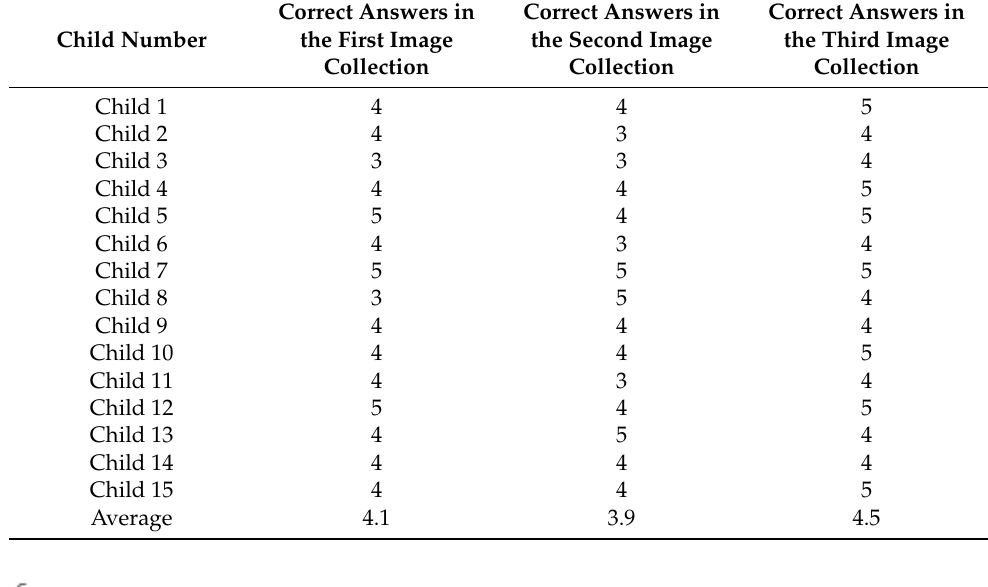
Table 2. Caregivers’ reports showing the correct answers for the TD children’s interaction with the three face collections on the first day.